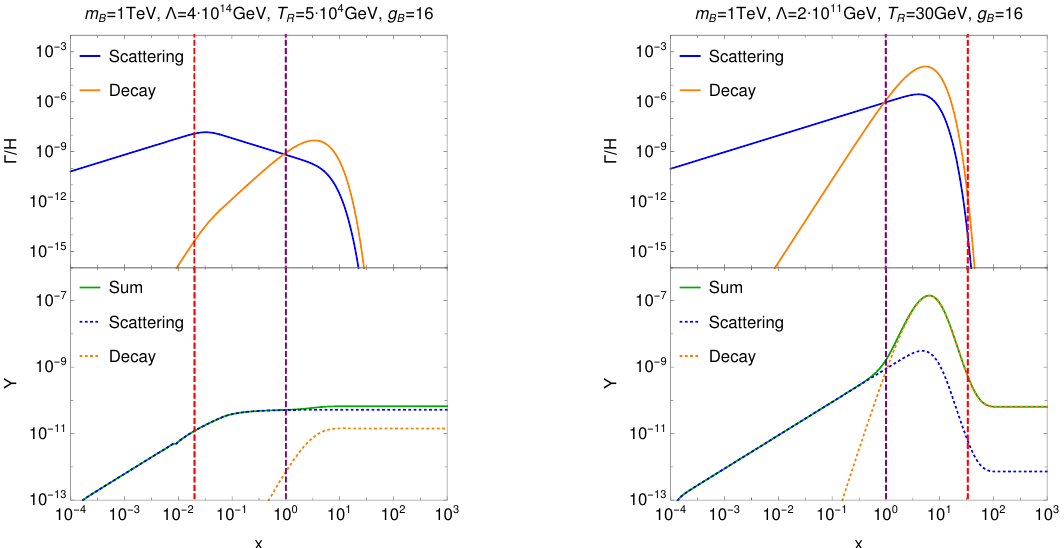
Figure 6. FIMP production via decays (orange) and scatterings (blue). The top panel depicts the ratio between interaction and Hubble rates while the bottom panel shows the total DM yield. We show two benchmarks with T (left) and T (right). The dashed vertical lines R > m B R < m B denote T = T (red) and T = m (purple). For these parameters, the observed DM abundance is R B reproduced for m = 10 DM